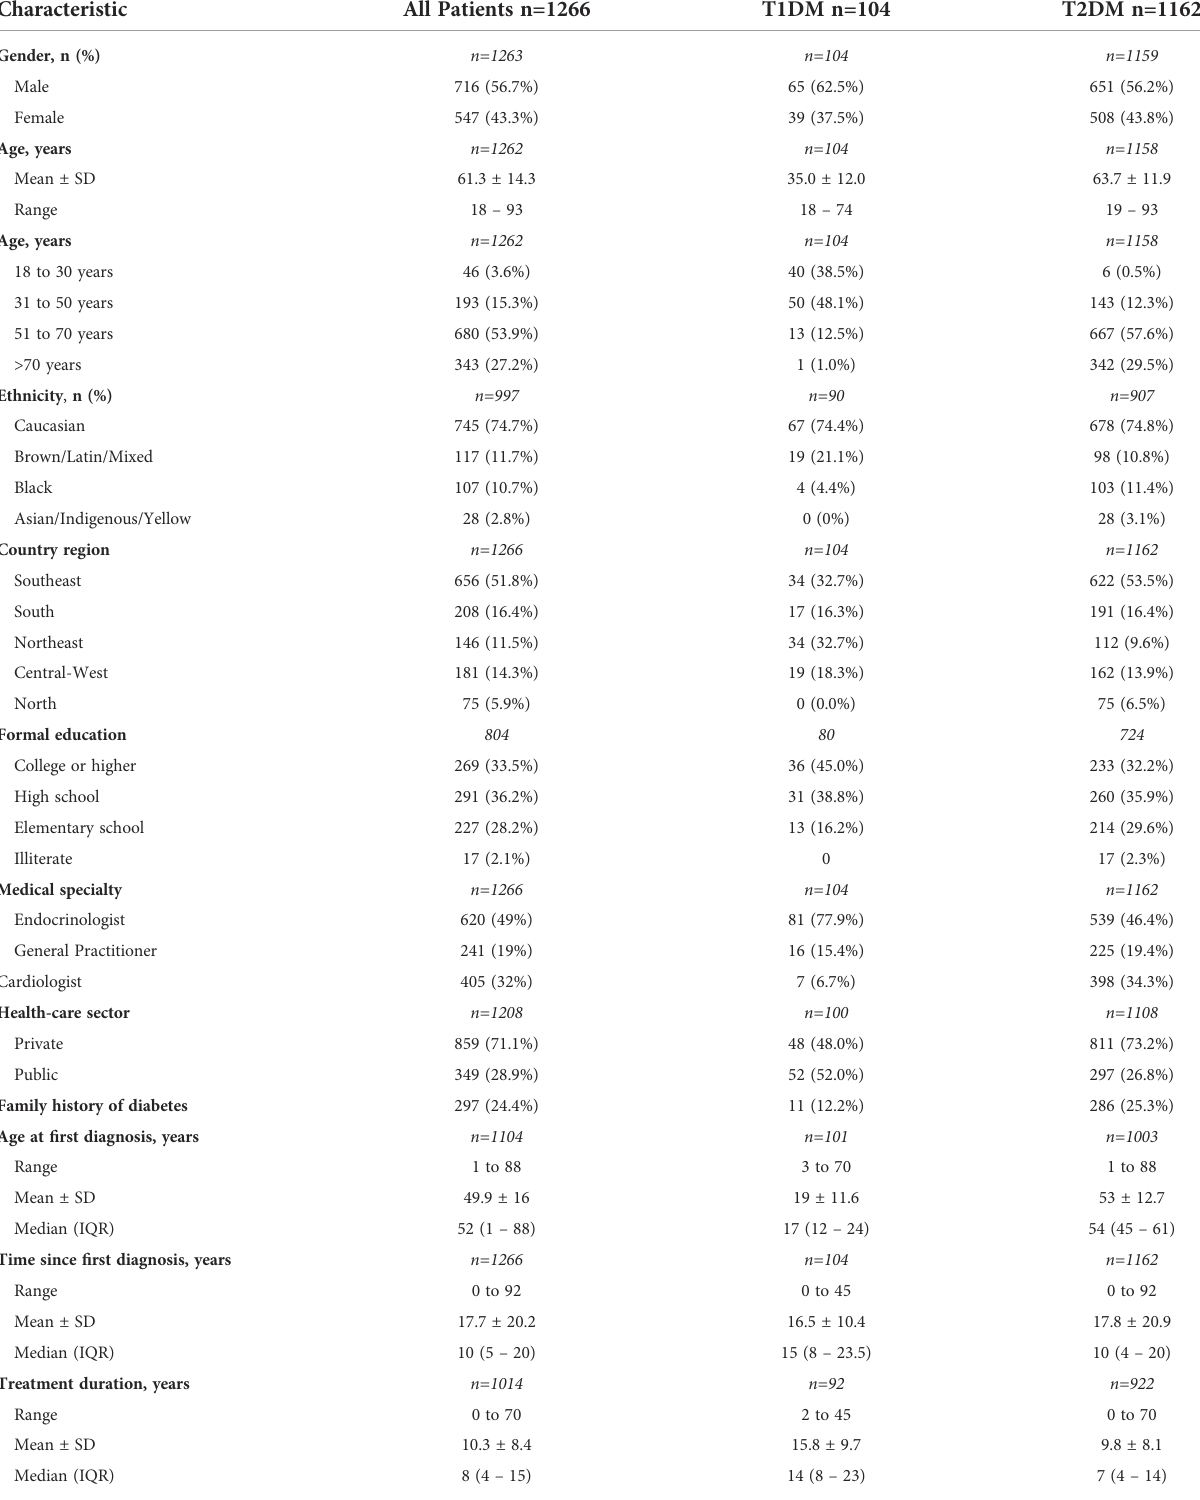
TABLE 1 Demographic and clinical